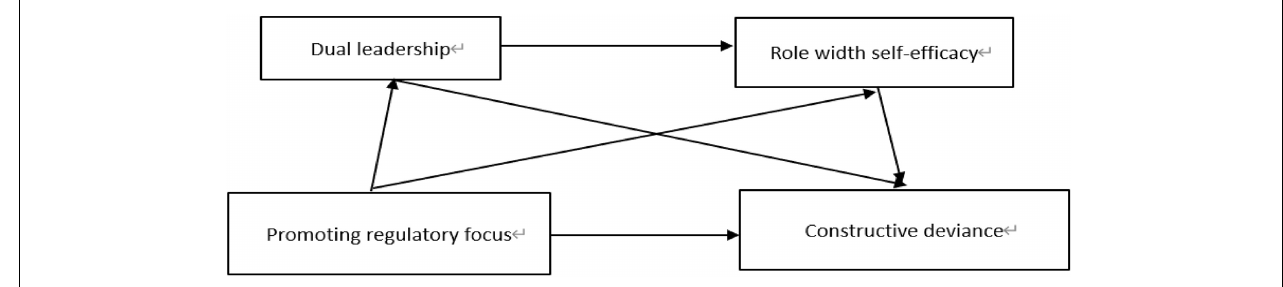
FIGURE 1 | Theoretical model between dual leadership and constructive deviant